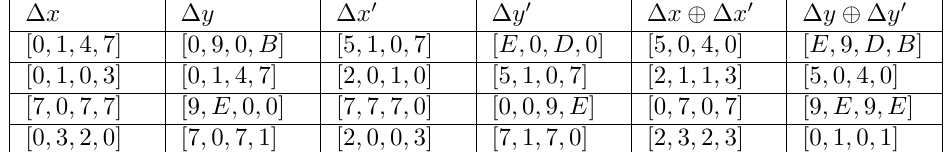
Table 2: The sets of byte-related differentials over AES